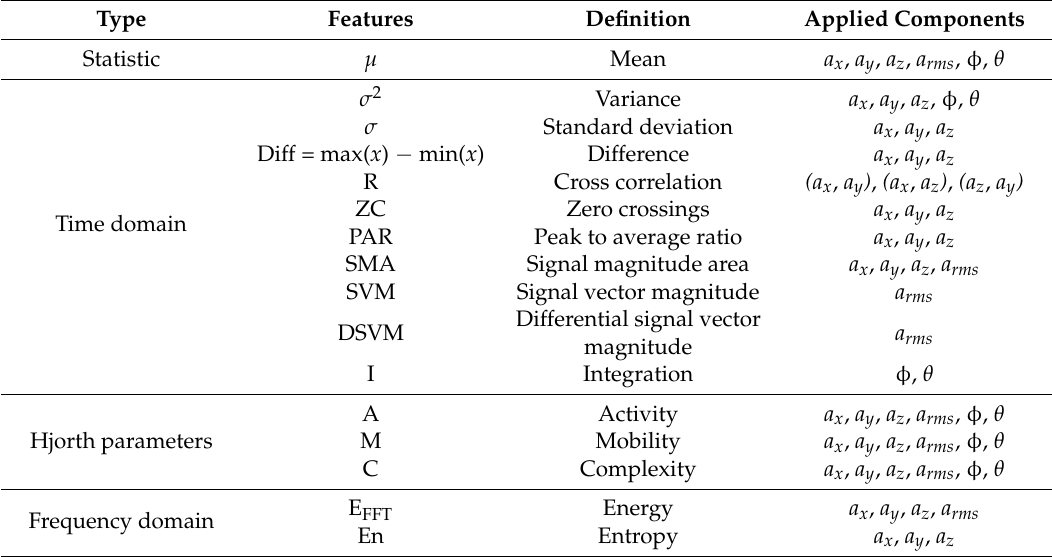
Table 3. Feature lists used in the proposed